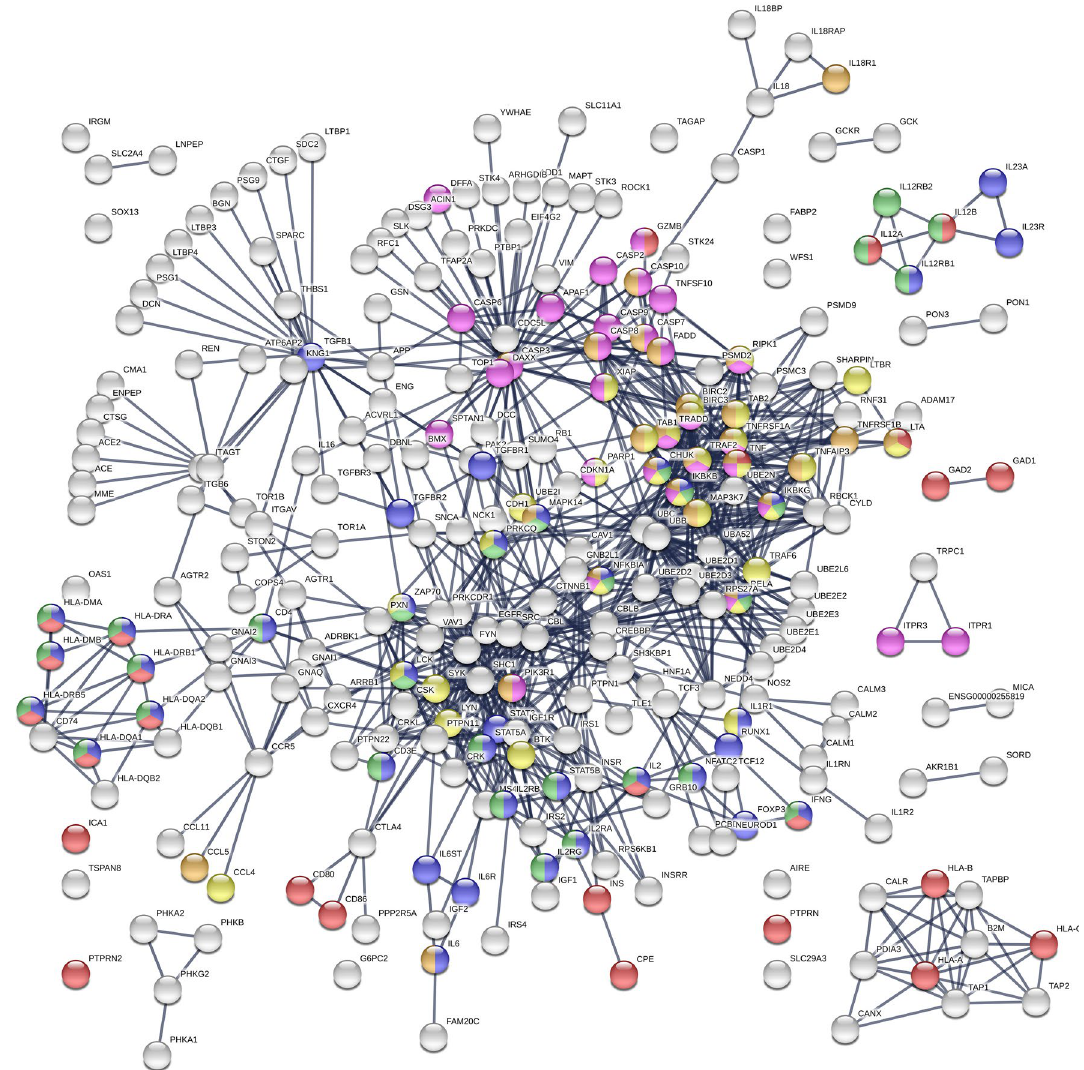
Figure 2. The KEGG pathways in the PPI network of T1D. The nodes involved in Th17 cell differentiation (hsa04659), type 1 diabetes mellitus (hsa04940), Th1 and Th2 cell differentiation (hsa04658), NF-kappa B signaling pathway (hsa04064), apoptosis (hsa04210), and TNF signaling pathway (hsa04668) were colored in blue, red, green, yellow, pink, and orange, respectively. The KEGG information were from KEGG database 22,23 . The PPI network was generated using STRING v11.0 26 (https:// string- db.